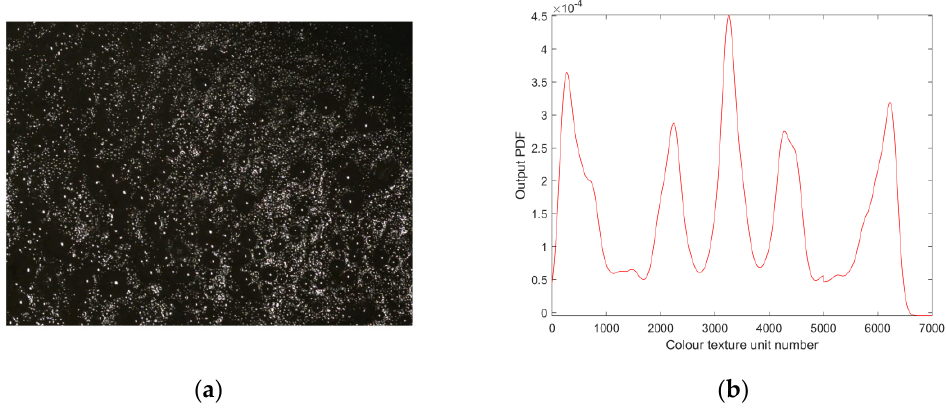
Figure 4. ( a ) Mineral flotation froth images in flotation cell are collected online. ( b ) Color texture unit distribution of mineral flotation froth images.